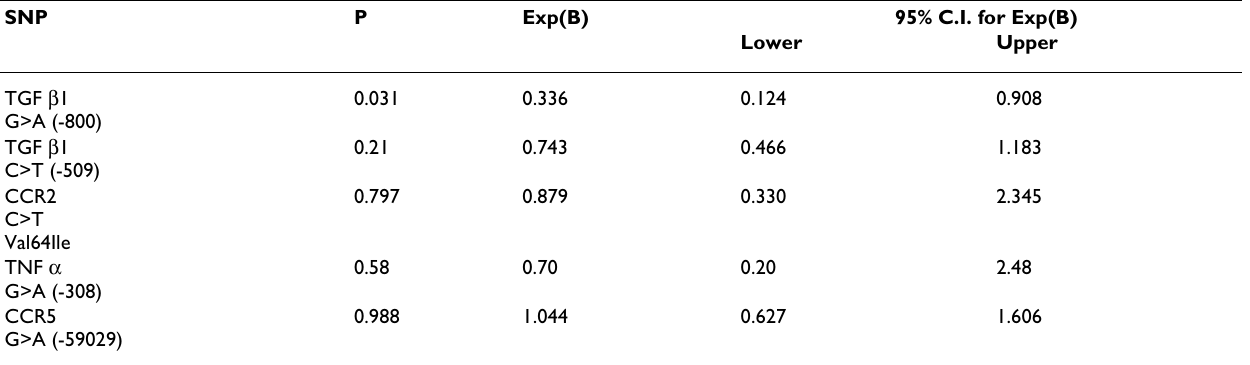
Table 3: A sub-analysis of case (CRI) category using proliferative retinopathy as an outcome variable SNP P